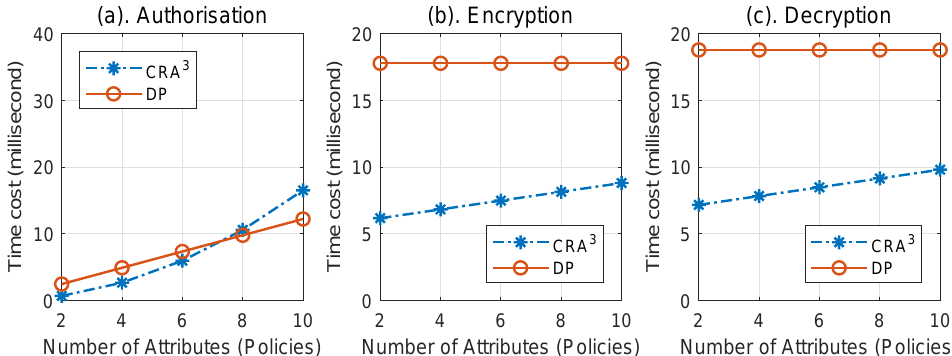
Figure 3. The time cost comparison of local computation on a Raspberry Pi 2 between CRA 3 and DP ( Decentralise Privacy scheme [12]).